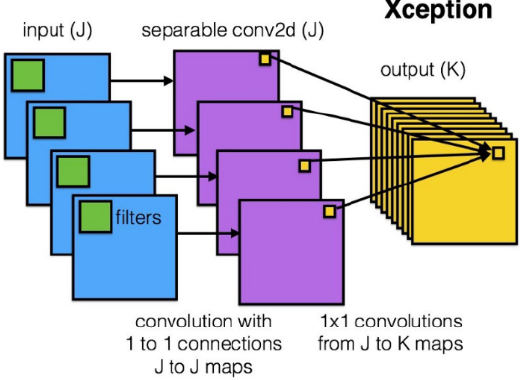
Figure 1. Depthwise separable convolution (Reprinted from ref. [12]).